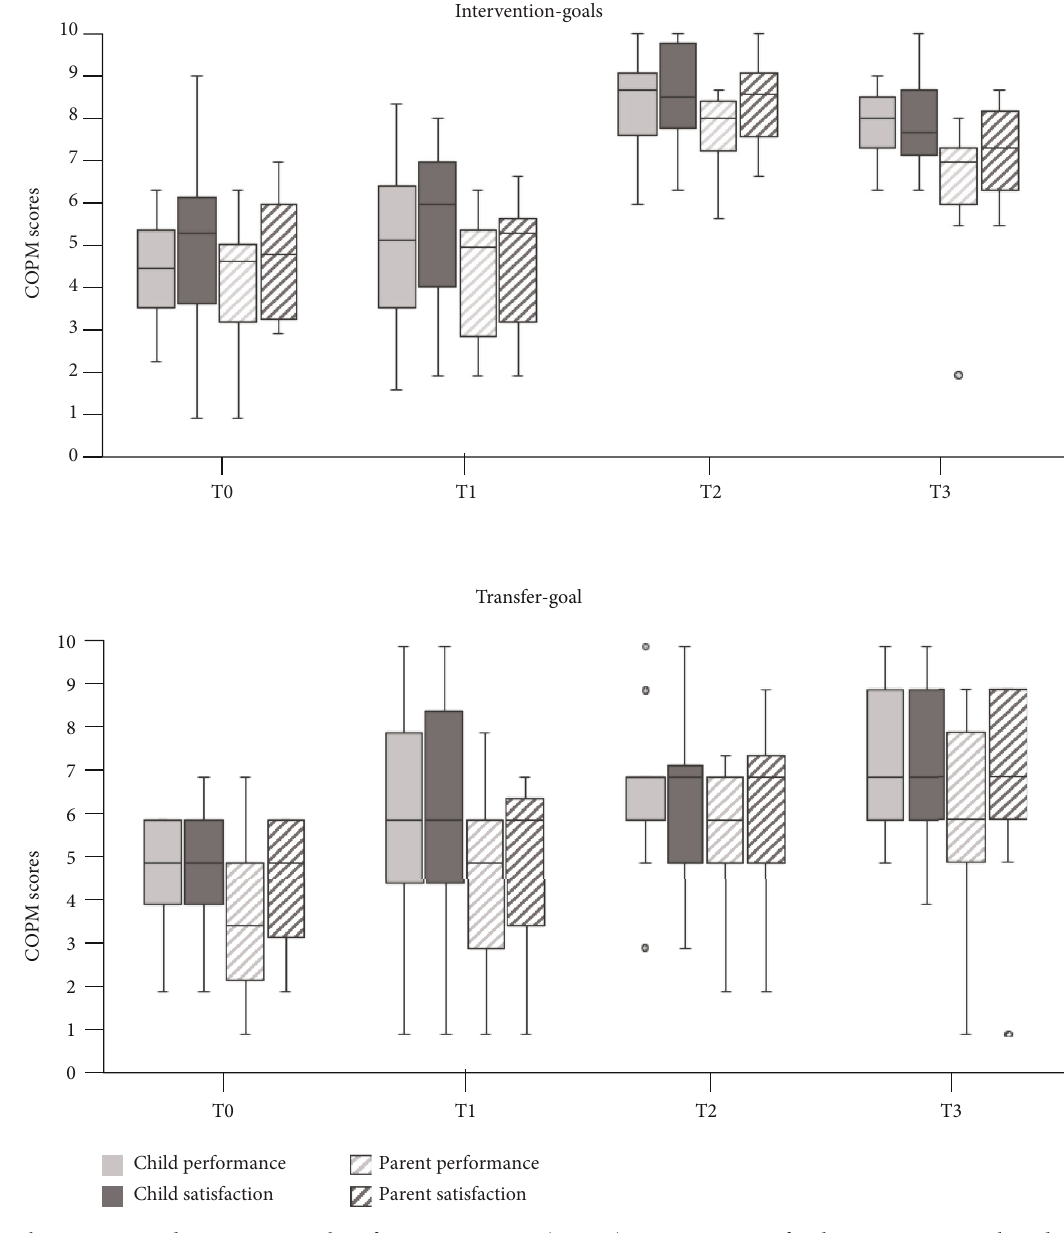
Figure 3: Changes in Canadian Occupational Performance Measure (COPM) scores over time for the intervention goals and transfer goal separately. The boxplots show the median, the fi rst and third quartile, the range, and the